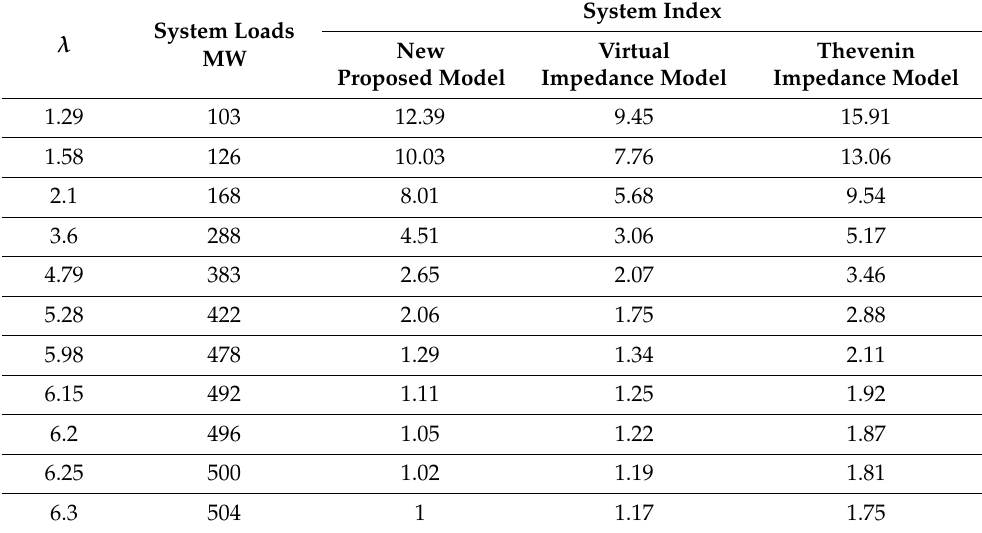
Table 5. Voltage stability system indices for the loop topology of five-bus system with G 2 and l 24 in operation as all loads increase.